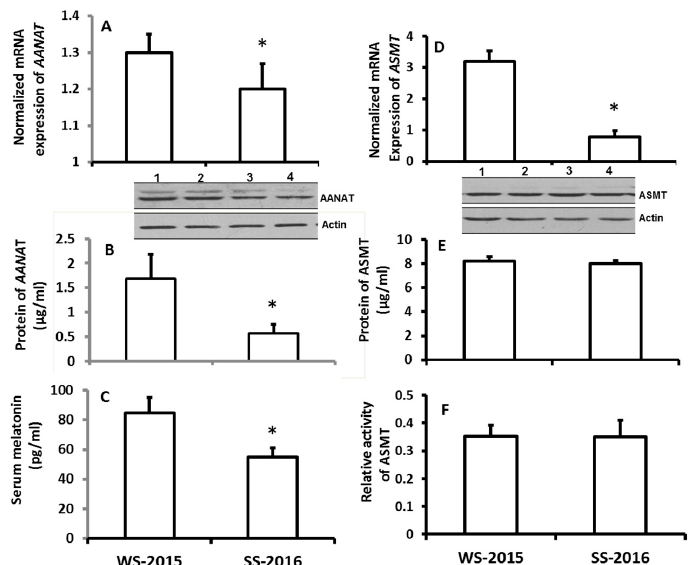
Figure 1. The effects of naturally seasonal alterations on the expression of melatonin synthetic genes, AANAT and ASMT , in the pineal gland and on melatonin production in hamsters. The animals were raised on the natural climate conditions (local environmental temperature, photoperiod and humidity) for one months and these animals were sacrificed at 9–10 pm on the days of winter solstice 2015 (WS-2015) or summer solstice 2016 (SS-2016), respectively. Pineal glands were collected for melatonin synthetic gene expression assay and serum was collected for melatonin assay. Animals were sacrificed under dim red light. The inserts were the images of Western Blots of the proteins of AANAT and ASMT , respectively. In panel B , the AANAT proteins of lines 1 and 2 were from the samples of WS-2015, line 3 and 4 were from SS-2016. In panel E , the ASMT proteins of lines 1 and 2 were from the samples of WS-2015, line 3 and 4 were from SS-2016. A and B : mRNA and protein levels of AANAT , respectively; C : Serum melatonin level; D , E and F : mRNA, protein levels and activity of ASMT , respectively. The data were expressed as means ± SDs of 16 hamsters each group. The gene expressions were normalized against housekeeping gene actin and the changes was analyzed with the 2 −(cid:52)(cid:52) Ct method. * Significant difference vs.